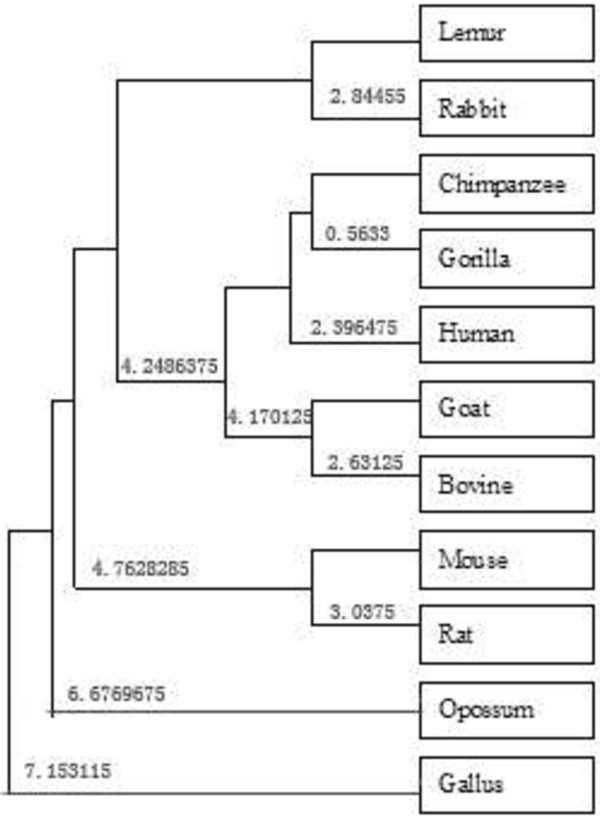
Phylogenetic tree based on the similarity matrix (Table5).